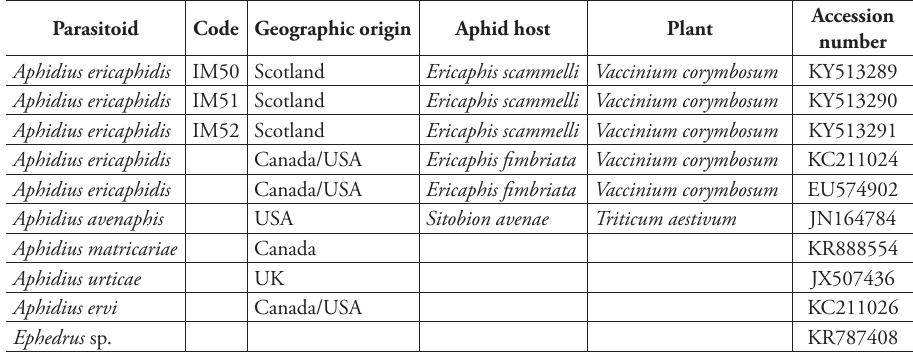
Table 1. Sampling data for Aphidiinae specimens used in the molecular analysis.